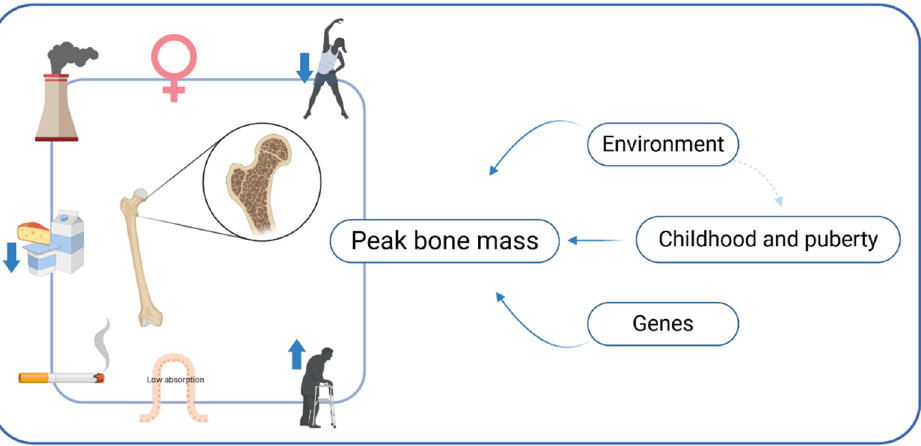
Figure 1. Risk factors of osteoporosis.